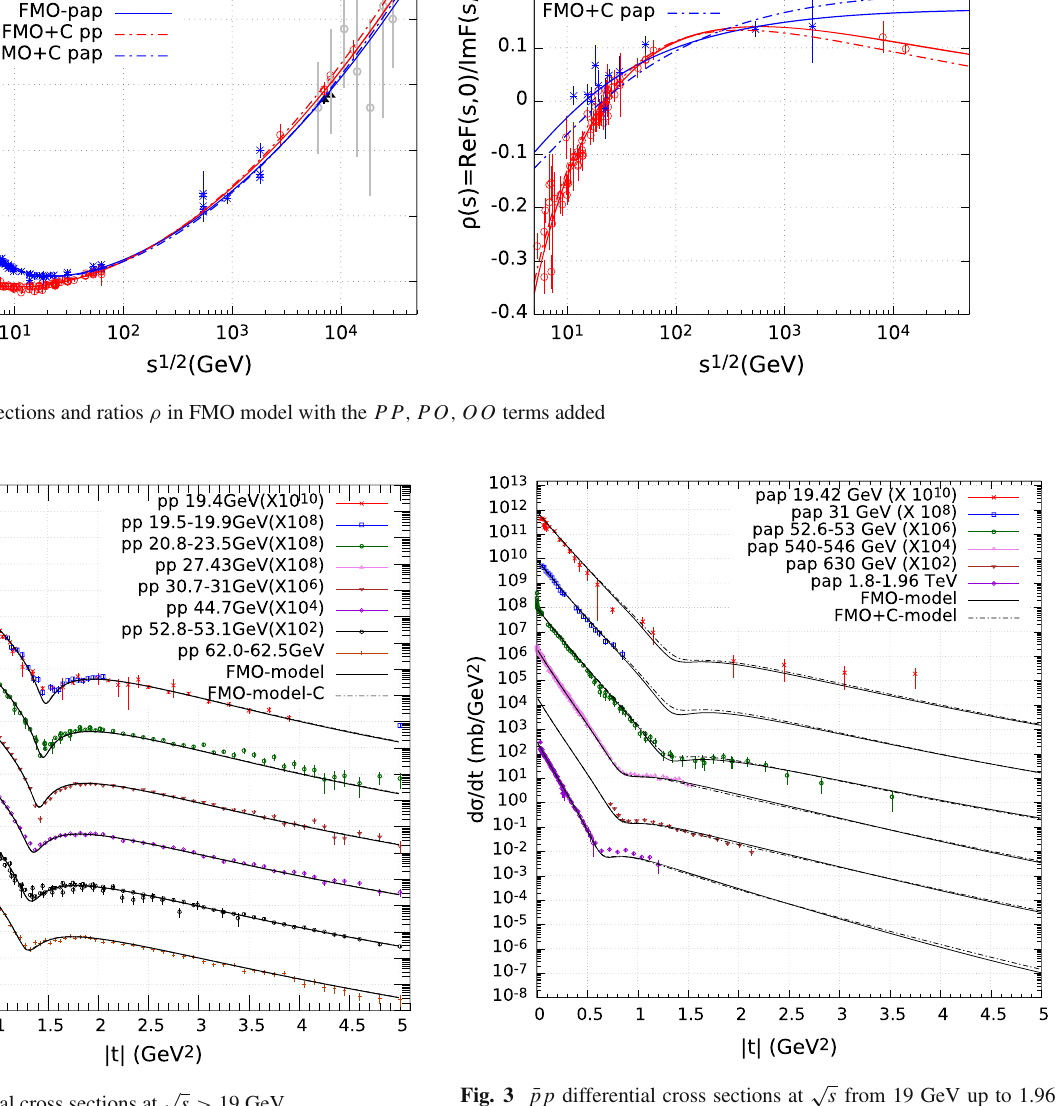
Fig. 2 pp differential cross sections at